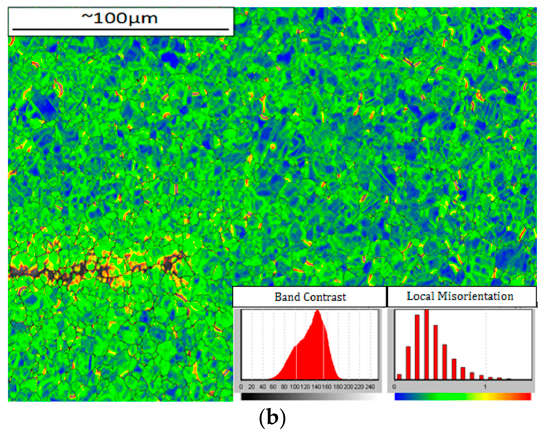
Figure 13. Intergranular cracking from IP testing shown by ( a ) an SEM image presenting crack branching and ( b ) an EBSD image of the crack tip.